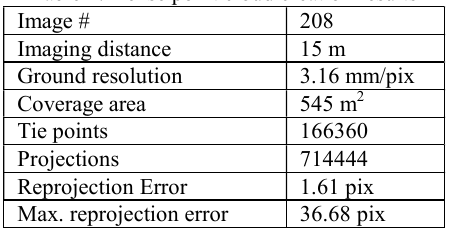
Figure 8. Dense 3D point cloud model of central circle dome Table 1. Dense point cloud creation results